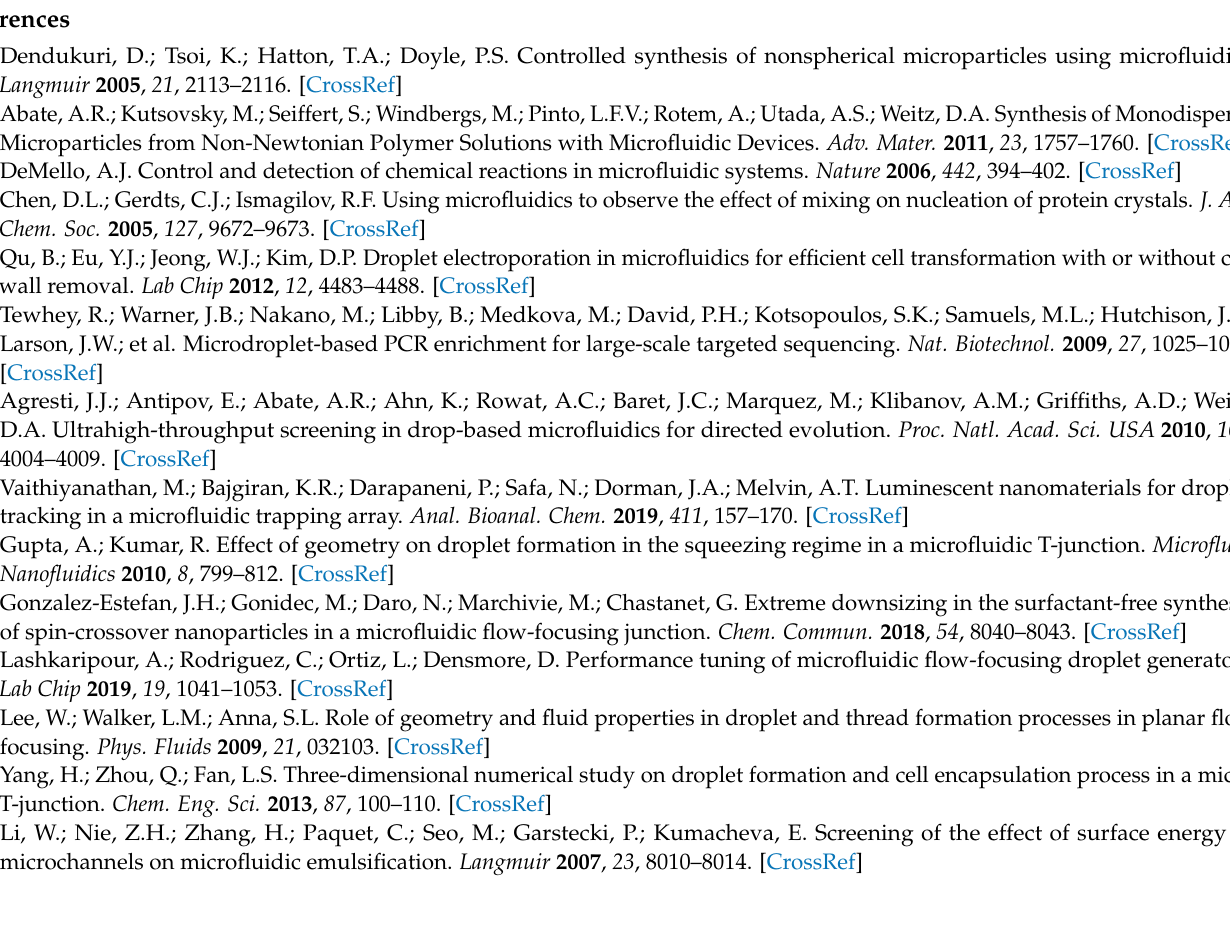
Figure S3: Quantification of gravity-driven flow rates as a function of height using three aqueous inlets the absence of oil flow, Video S1: Snapshot of simultaneous droplet generation in three active inlets using gravity-driven flow, Table S1: Evaluating the predictive capability of the model, Table S2: Statistical comparison of mean droplet diameter between different Φ values using active Inlets 1 and 2 experiment, Table S3: Statistical comparison of mean droplet diameter between different Φ values using active Inlets 1 and 3 experiment, Table S4: Statistical comparison of mean droplet diameter between different Φ values using active Inlets 2 and 3 experiment, Table S5: Statistical comparison of mean droplet diameter between different Φ values using active Inlets 1, 2, and 3 experiment, Table S6: ANOVA on the mean droplet generation rate for all three active aqueous inlets for a specific oil-to-water ratio ( Φ ) value using gravity driven flow., Table S7: Statistical comparison of mean droplet generation rate between different Φ values using active Inlets 1 and 3